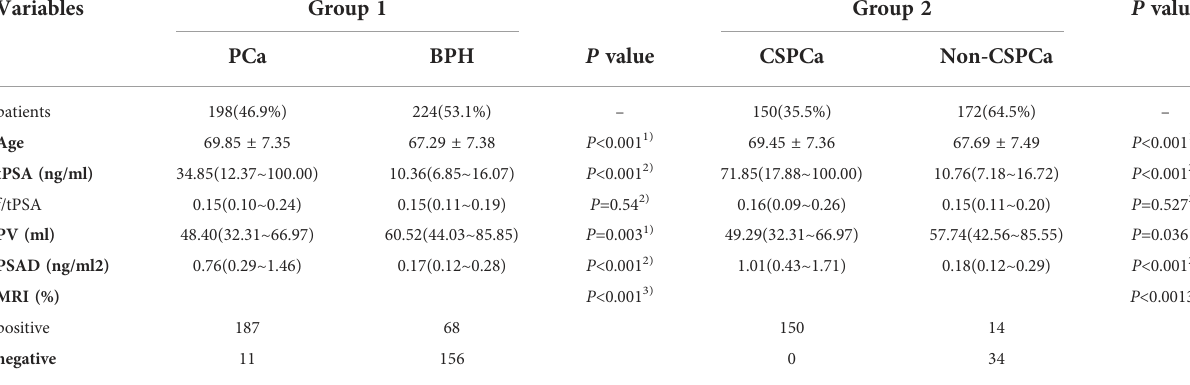
TABLE 2 Univariate analysis of the Clinical Characteristics in the different